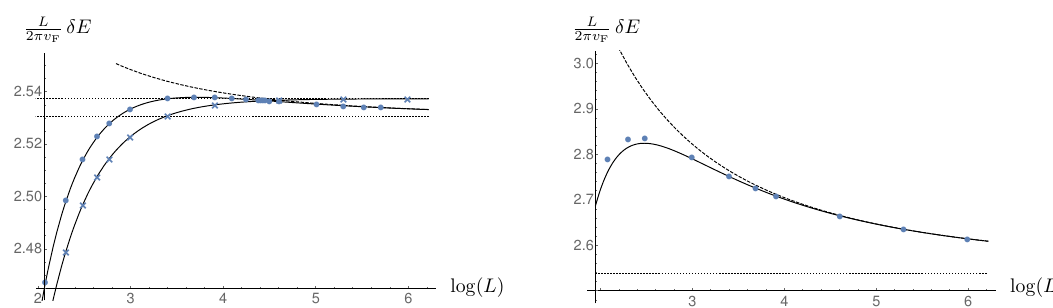
Figure 14. Numerical data obtained from the solution to the BA equations for the winding states with w = 1, S z = 0, m = 0 (left panel) and m = 2 (right panel) is depicted for (cid:14)E (cid:17) E (cid:0) v F e 1 L . On the left panel the crosses and circles correspond to the RG trajectories whose representatives for L = 20 are shown on the left and right of (cid:12)gure 7, respectively. On the right panel, the points correspond to the state whose typical pattern of Bethe roots is displayed in (cid:12)gure 9. Note that L ranges from L = 8 to L = 1000. In both panels the dashed lines come from the asymptotic formula eq. (86) taking account only the L (cid:0) 1 terms, while to compute the solid lines the L (cid:0) 3 correction was included. The dotted horizontal lines show the limiting values of L (cid:14)E . The value of s ( L ) 2 (cid:25)v F entering into the r.h.s. of eq. (86) was calculated using the quantization condition (23) with m = 0 (left panel) and m = 2 (right panel). The parameters are set to be the same as in (cid:12)gure 7, i.e., (cid:13) = (cid:25) and k = 1 5 25